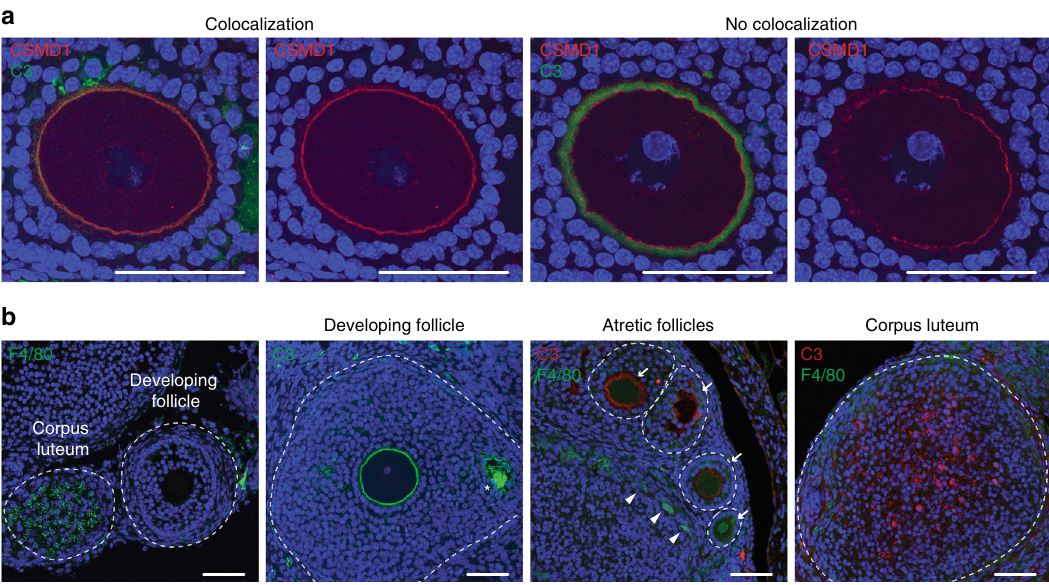
Fig. 6 C3 and CSMD1 protein colocalize at the oocyte surface. a Spatial relationships between C3 and CSMD1 in developing follicles. C3 and CSMD1 immuno fl uorescence of oocytes in developing follicles. In most follicles, C3 and CSMD1 colocalize at the oocyte plasma membrane with overlapping signal (Colocalization, left panels). Occasionally the two signals separate and C3 is localized in a tight but distinct ring outside of CSMD1 (no colocalization, right panels). b Spatial relationships between C3 and F4/80-positive macrophages in developing, atretic, and post-ovulatory follicles. F4/80 immuno fl uorescence of adjacent follicles shows positive macrophage signal in corpus luteum, but not within developing follicles. C3 is localized to the oocyte membrane, as well as in the follicular fl uid of the developing antrum (asterisk). Atretic follicles at different stages of degeneration (white arrows) show varying levels of C3 and F4/80 expression. F4/80 can also be seen in a punctuated pattern along the stroma and thecal layers (white arrowheads). C3 is also present in corpus luteum. Individual follicles are circumscribed by dashed lines. All scale bars = 50 μ m. Source data are provided as a